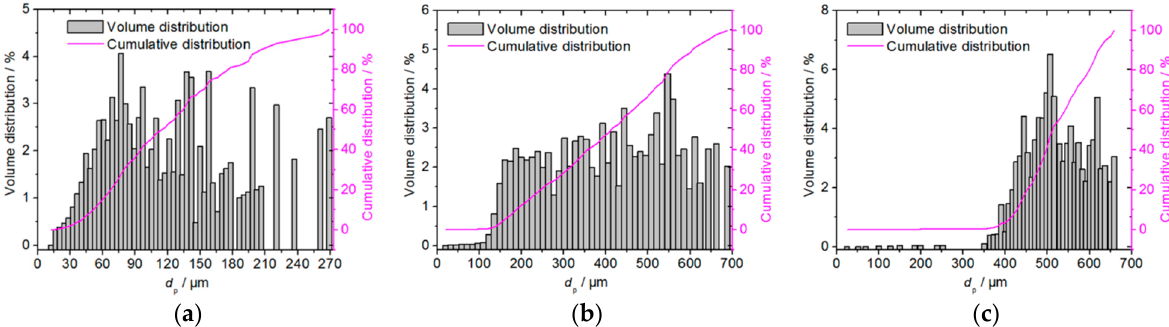
Figure 8. Size distribution of the sand particles used in the test: ( a ) D 32. = 65 μ m; ( b ) D 32 = 226 μ m; ( c ) D 32 = 336 μ m.